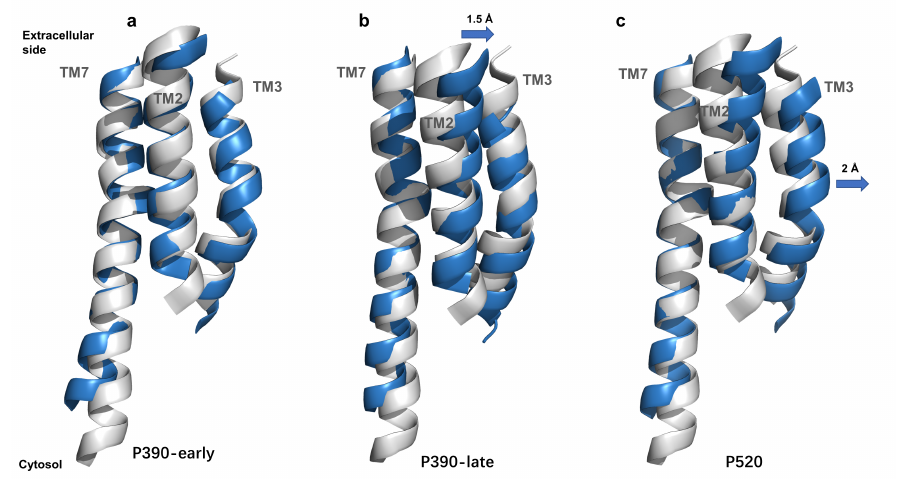
Figure 5. The superposition of C1C2 4ms crystal structure (gray) and simulated intermediates (blue). ( a ) P390-early state. ( b ) P390-late state. ( c ) P520 state. The blue arrows in ( b , c ) indicate the displacement of the helices of the simulated conformations over that of the C1C2 4 ms structure shifted outwards,